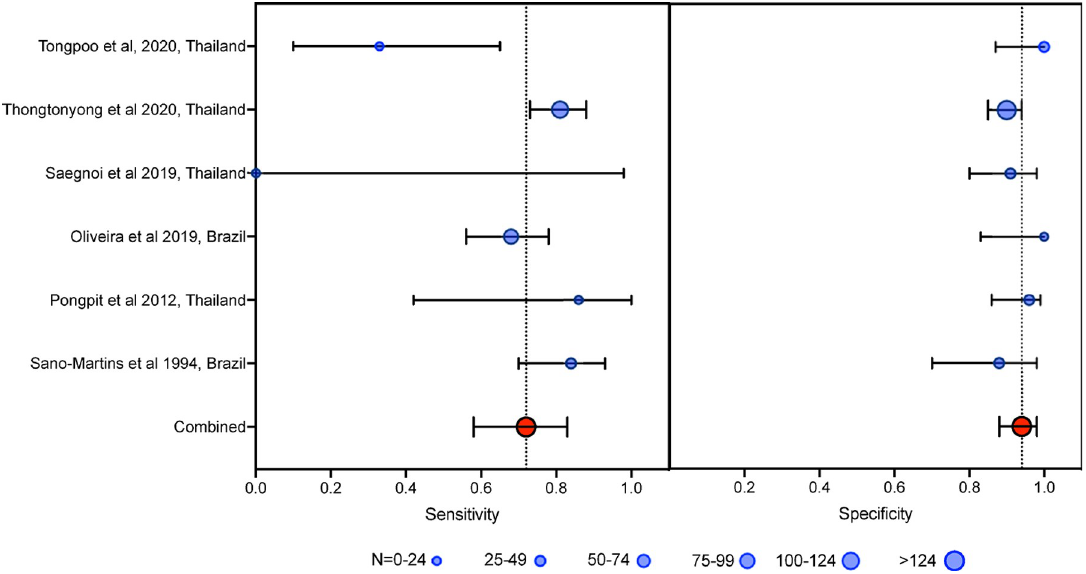
Fig 4. Forrest plot of 20WBCTsensitivity and specificityat detecting coagulopathydefined as fibrinogen < 100mg/dL. Studiesdisplayed individually and pooled. Circlesize is proportional to sample size, whiskersrepresent95% confidence